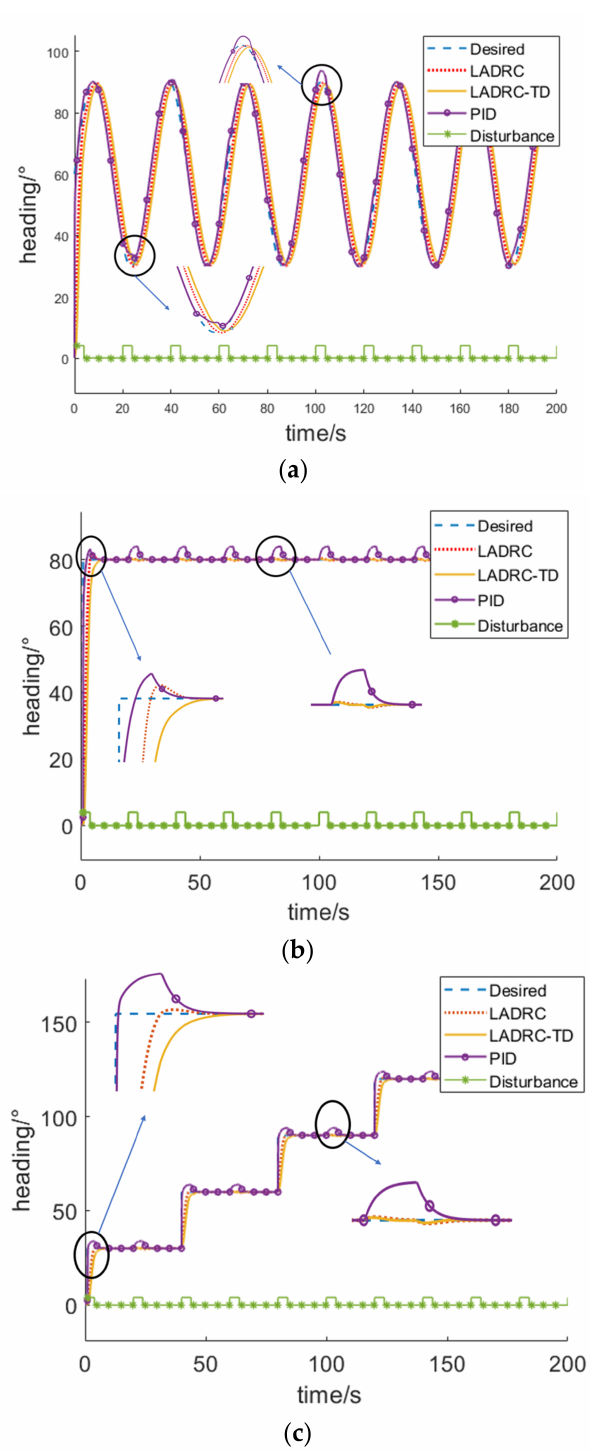
Figure 8. Simulations of heading control with PID, LADRC, and LADRC-TD; ( a ) heading tracking with the sinusoidal signal; ( b ) long-span-step response; ( c ) multi-step